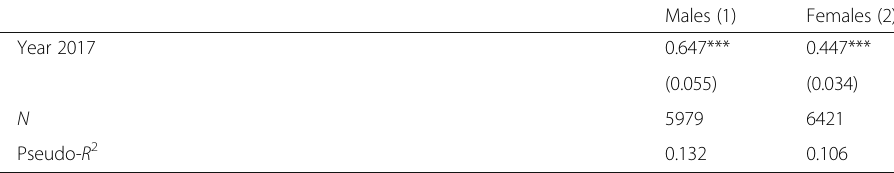
Table 1 Correlates of virginity status among Italian students, odds ratios